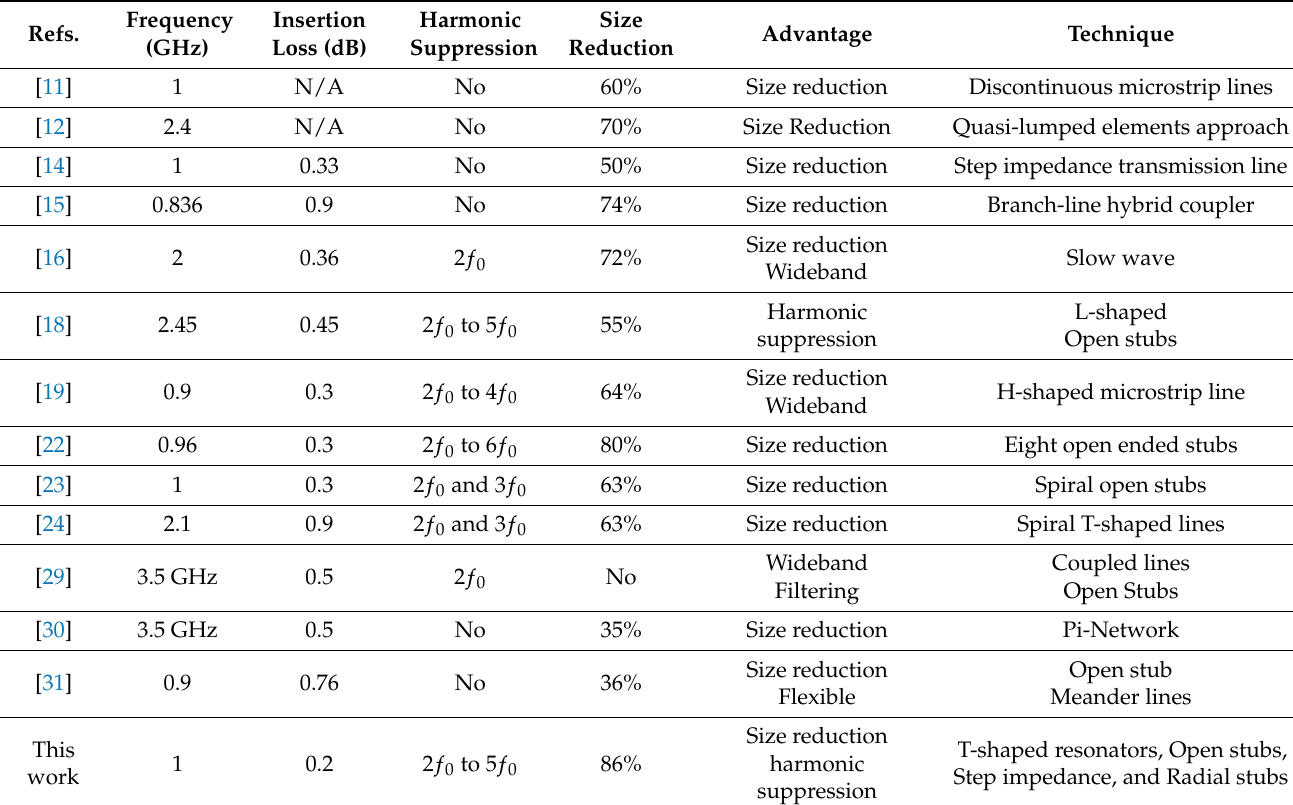
Table 2. Performance comparison between the proposed BLC and the recent ones.